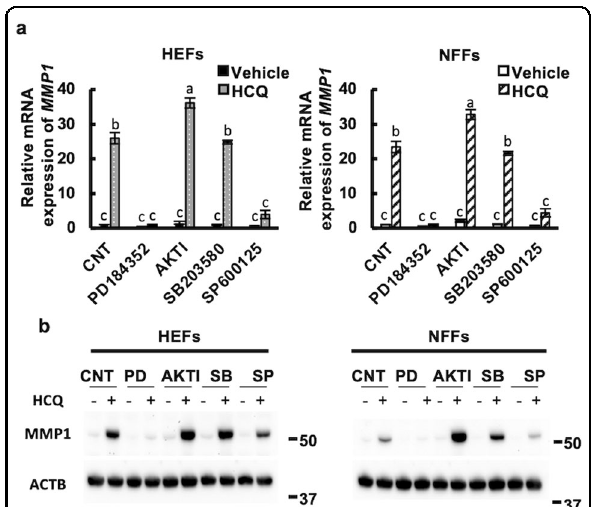
Fig. 6 ERK phosphorylation is crucial for MMP1-inducing activity of HCQ. HEFs (KYU168) and NFFs (KYU101) were treated with 50 μ M HCQ and phosphorylation inhibitors of the MAPK pathway for 24 h; MMP1 mRNA ( a ) and protein ( b ) expression is shown. PD: 10 μ M PD184352 (ERK inhibitor), AKTI: 5 μ M (AKT inhibitor), SB: 10 μ M SB203580 (p38 MAPK inhibitor), and SP: 10 μ M SP600125 (JNK inhibitor). The data represented the mean ± SD of the three independent experiments ( a ). The different letters (a, b, c) above the bars indicate statistically signi fi cant differences ( P <